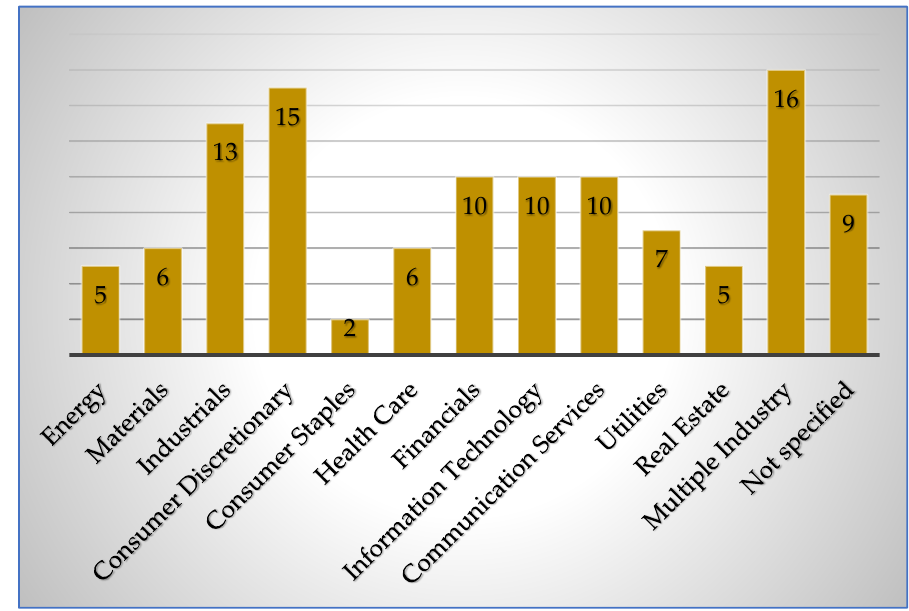
Figure 6. Articles by MSCI industry classification .